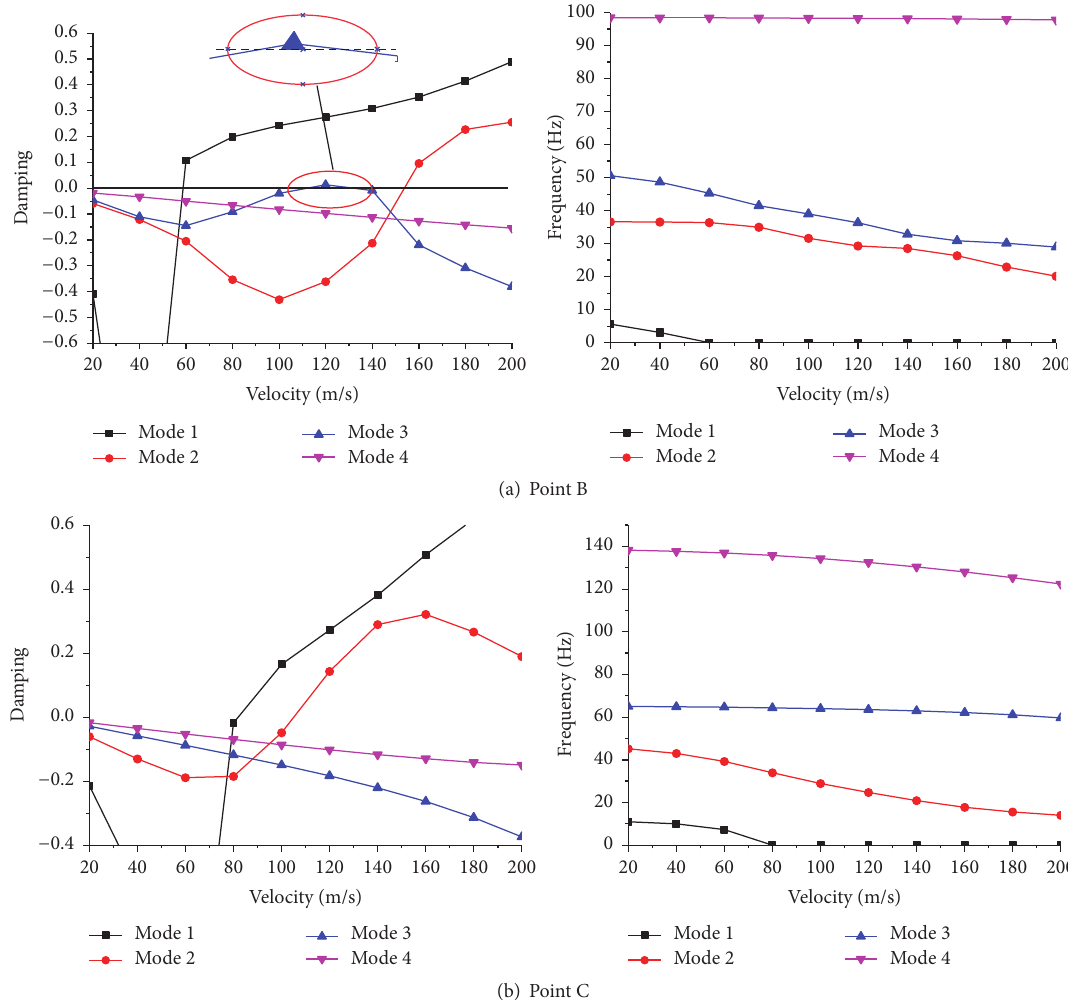
Figure 7: 𝑉 - 𝑔 and V - 𝑓 curves of the two